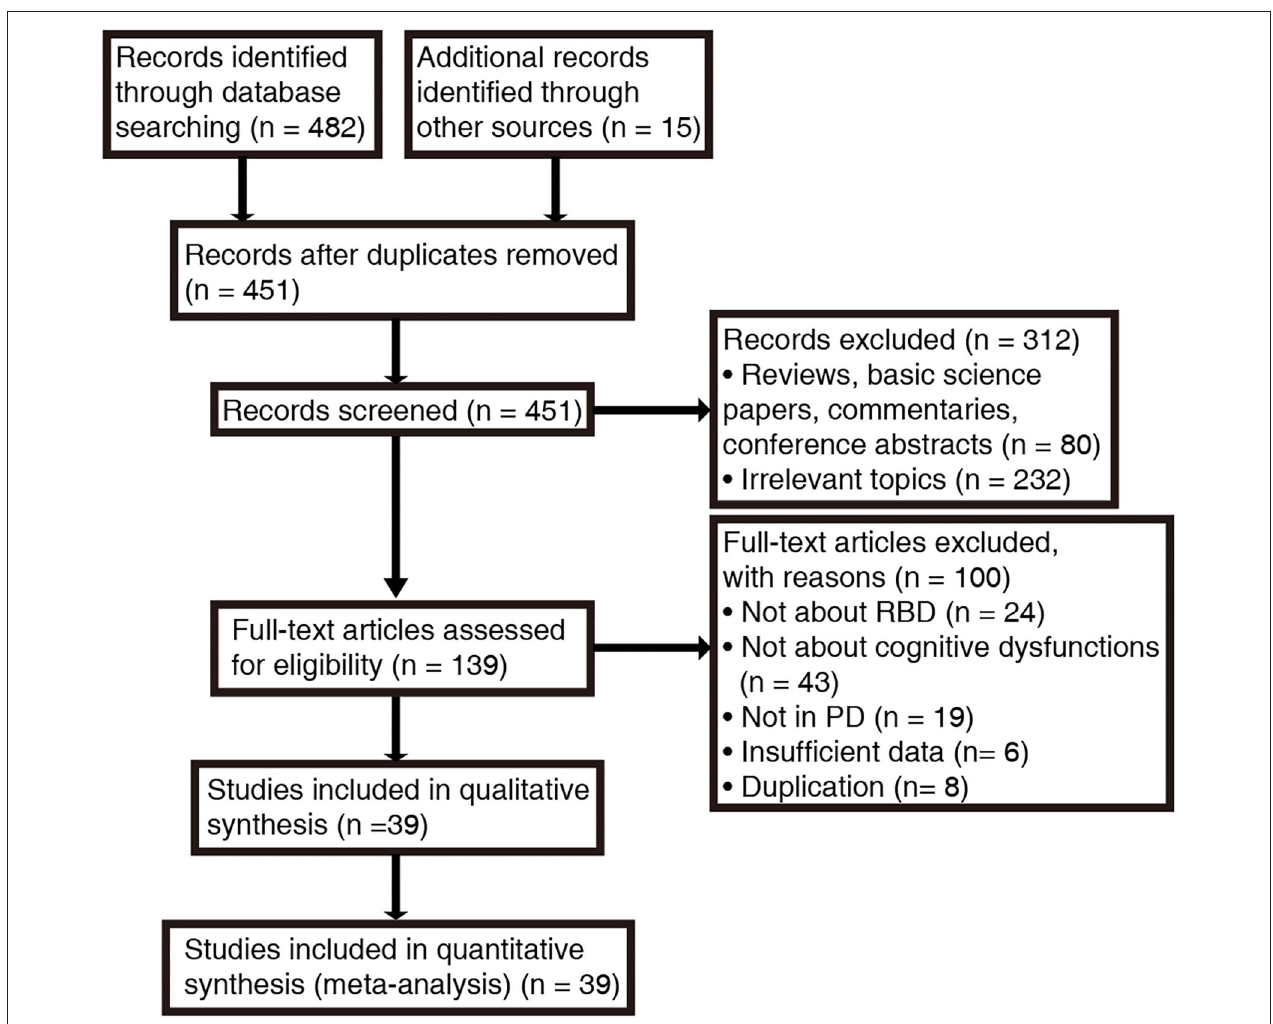
FIGURE 1 | Search procedure and results according to PRISMA guidelines. RBD , rapid eye movement sleep behavior disorder; PD , Parkinson’s